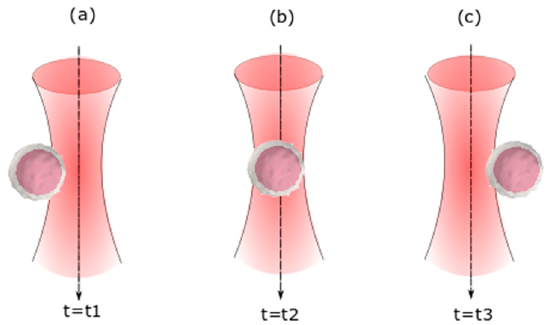
Figure 2. The individual cell passage through the laser beam at time point of ( a ) t1, ( b ) t2, ( c ) t3.